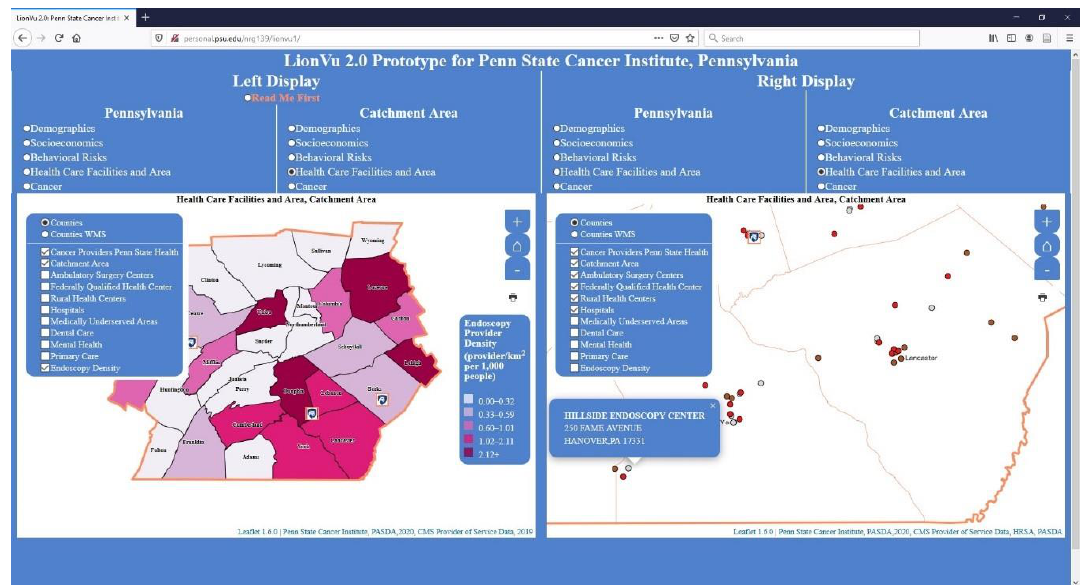
Figure 5. Screen shot of task 3. Left display: Endoscopy density (providers/km 2 per 1000 population) within catchment area. Right display: Health care providers (dots: Gray-Ambulatory Service Centers; Brown-Federally Qualified Health Centers; Red-Hospitals) within catchment area. Layer list was not collapsed in order to clarify what fields were available for selection.